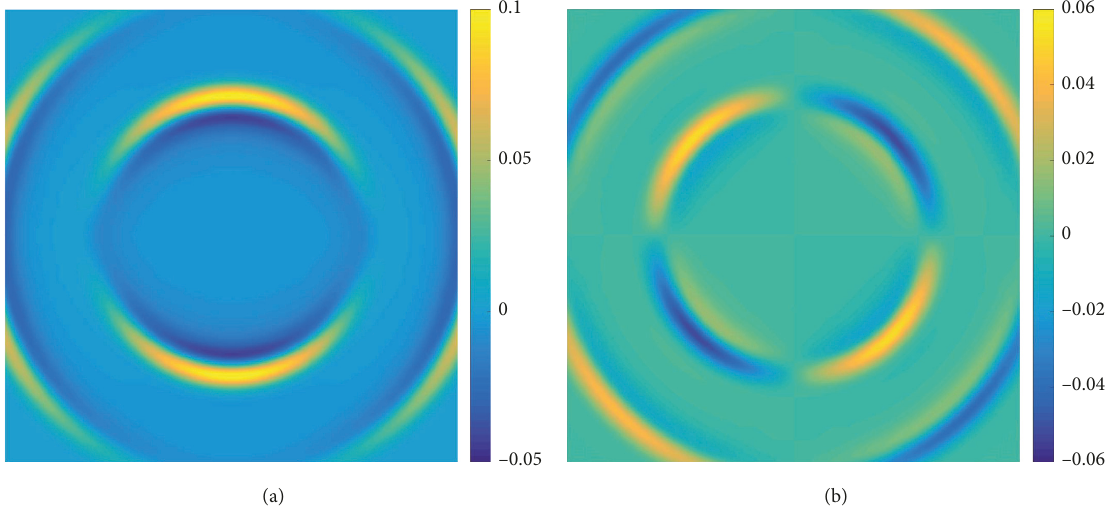
Figure 5: Velocity distribution in x and y directions at time � 0.9s. (a) x direction (b) y direction.